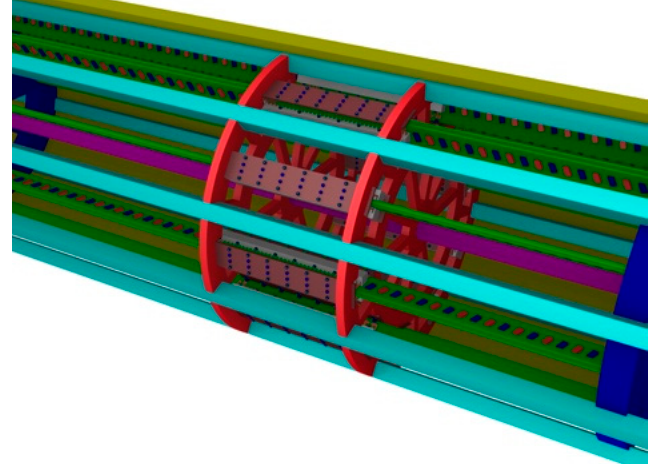
Figure 7. Internal view of the Department of Energy, Information Engineering and Mathematical Models (DEIM) point absorber.